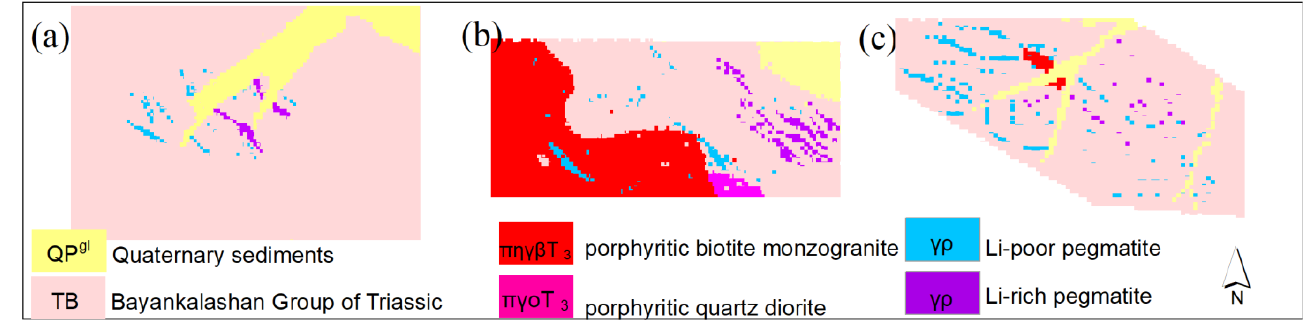
Figure 15. Classification map, based on the RF classifiers, with GF-5 AHSI data: ( a ) Akesayi mine, ( b ) 509 mine, and ( c ) Longmengshan mine.